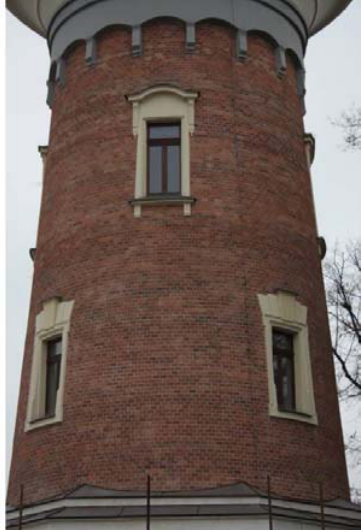
Figure 16. Example: the water tower lower part